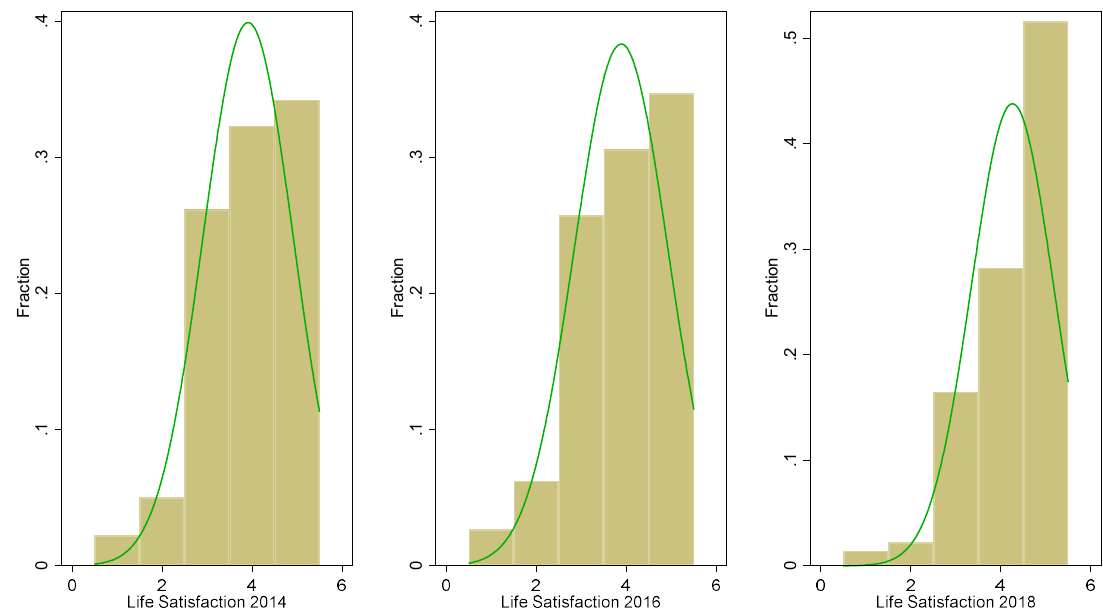
Figure 1. Distribution of life satisfaction 2014–2018.